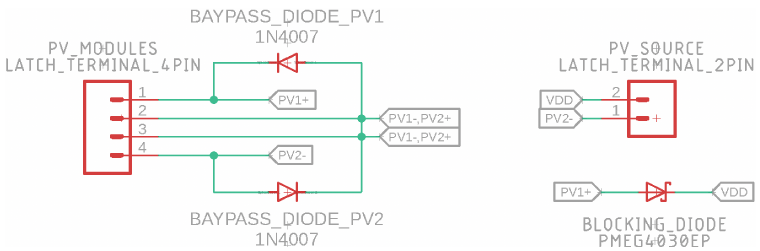
Figure 15. Schematic diagram of the circuit designed for PV module integration.